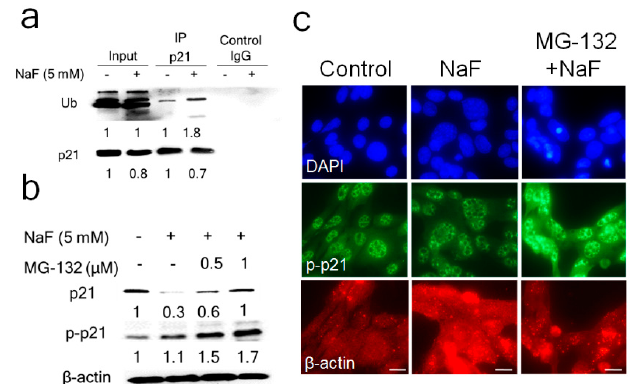
Figure 2. Fluoride increased Ub-p21 binding and MG-132 reversed the fluoride-mediated p21 protein decrease. ( a ) LS8 cells were treated with NaF (5 mM) for 6 h. Protein was immunoprecipitated using anti-p21 antibody and ubiquitinated-p21 (Ub-p21) was detected in the precipitated fraction by the anti-Ubiquitin antibody. Fluoride treatment increased Ub-p21 levels. IgG was used as the negative control. The numbers show relative protein expression vs. Controls (0 mM NaF). IP lanes were quantified separately from input lanes. ( b ) LS8 cells were treated with MG-132 (0.5–1.0 µ M) for 2 h prior to NaF (5 mM) treatment for 24 h. p21 (18 kDa) and p-p21 (21 kDa) were detected by Western blot. MG-132 reversed the fluoride-induced p21 suppression at 24 h by increasing p-p21 protein levels. The numbers show relative expression normalized by the loading control β -actin (44 kDa). Statistical analysis of relative protein expression of p21 and p-p21 are shown in supplementary Figure S5. ( c ) Cells were treated with NaF (5 mM) with / without MG132 (0.5 µ M) for 24 h and p-p21 (green), nucleus (DAPI; blue) and β -actin (red) were detected by immunocytochemistry. MG-132 treatment increased p-p21 protein